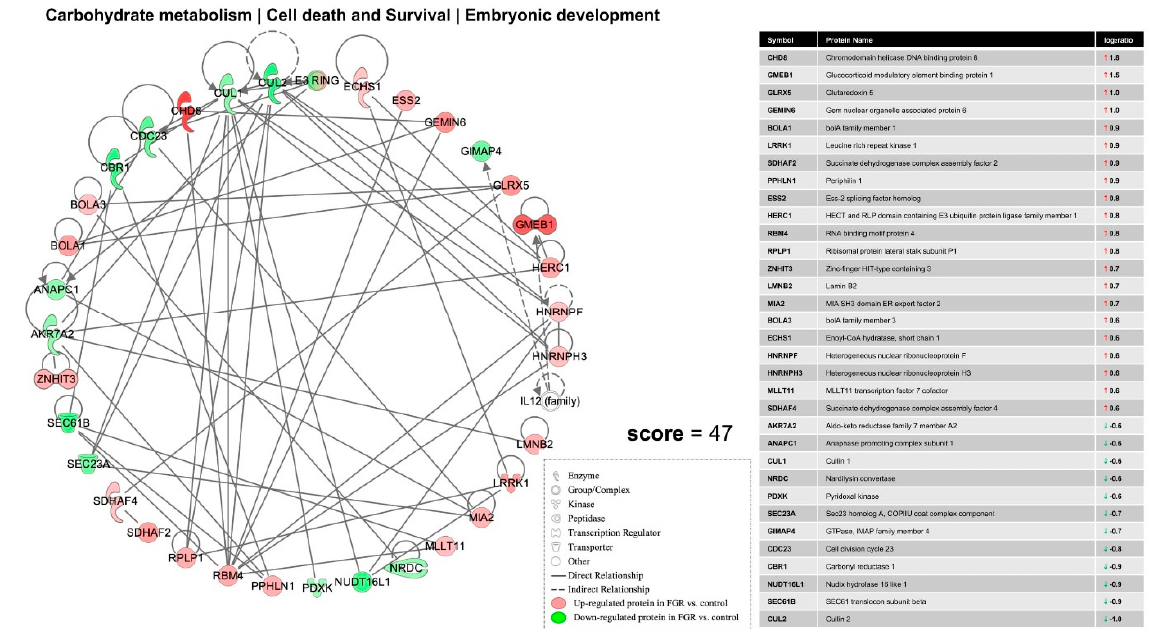
Figure 4. Ingenuity Pathway Analysis of differentially expressed proteins in FGR compared to control showed over-representation of a protein network related to carbohydrate metabolism, cell death and survival, and embryonic development.